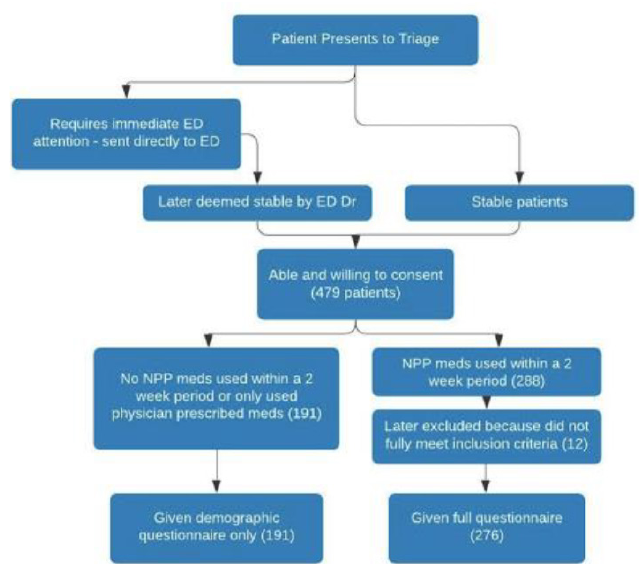
Figure 2. Enrollment criteria for stable patients in Cambodia studied for identification and knowledge of their current medications. ED , emergency department; NPP , non-physician